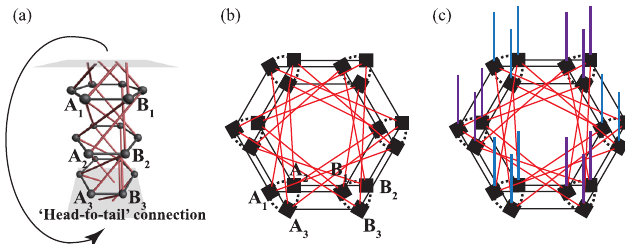
Fig. 1. A ball-and-stick model that illustrates the connectivity of the network. A tight-binding model can be de fi ned when hopping constants are speci fi ed for the bonds connecting the sites. (a) A 3D view of the tight-binding model. The A sites and B sites are sublattice sites of a hexagonal lattice in the x-y directions. (b) The 3D model is compressed onto a 2D plane and is realized by transmission lines. The dashed circles mean that a meta-atom is composed of three nodes. (c) Additional transmission lines are added to the nodes to tune the